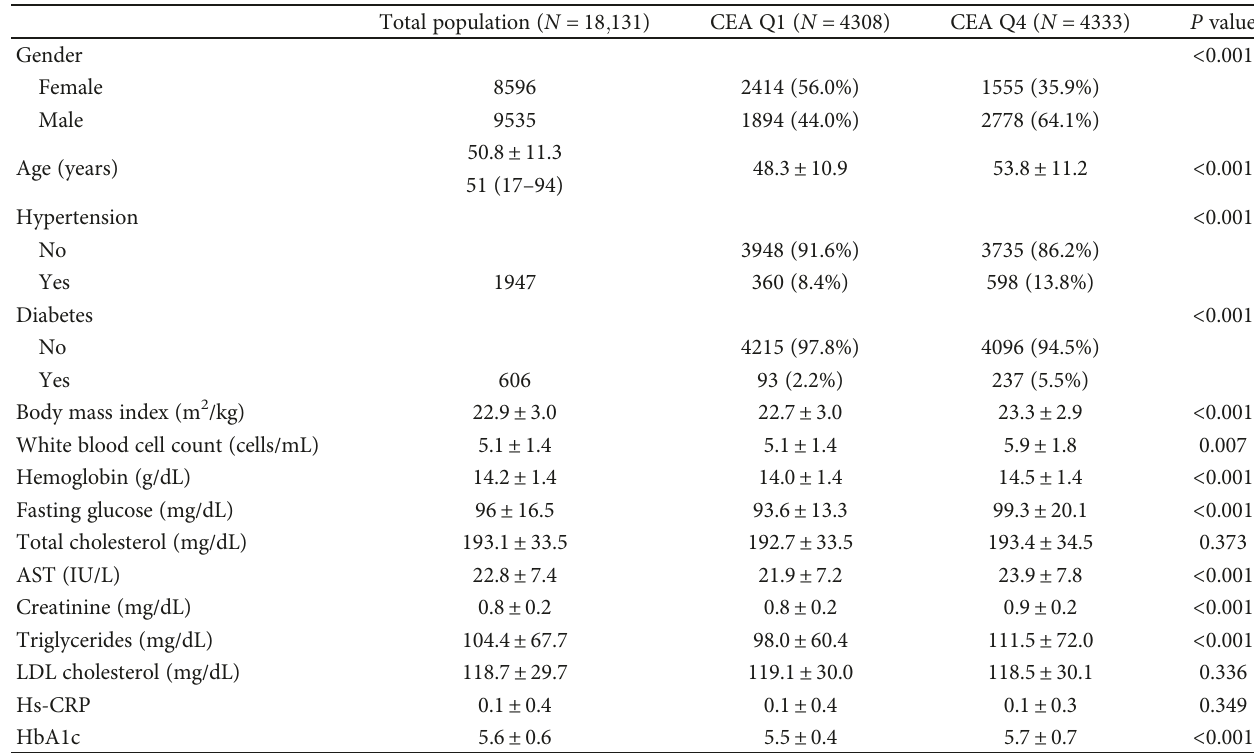
Table 1: Characteristics of the study